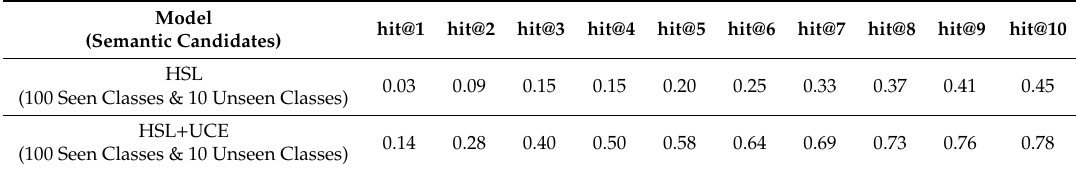
Table 2. Hit@k performance on generalized zero-shot cross-modal retrieval for unseen class visual data in